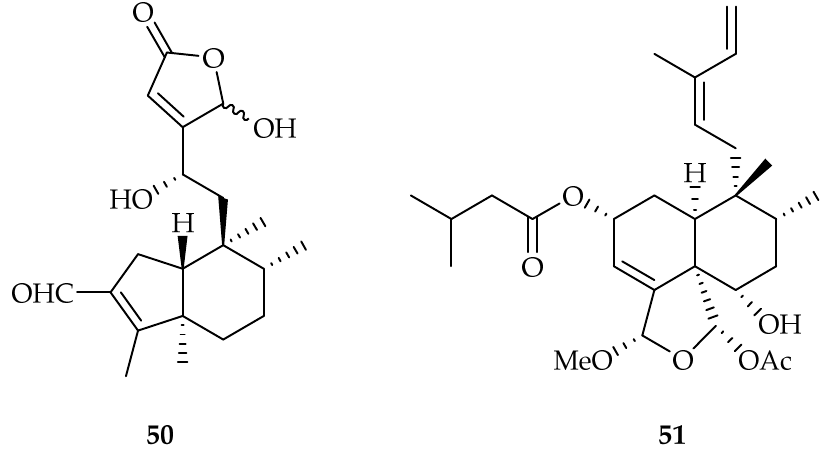
Figure 21. Structures of 16-hydroxy-pentandralactone 50 [33] and caseargrewiin M 51 [34]. Methanolic extraction and subsequent partitioning with EtOAc of the fresh ripe fruits of Cesearia grewiifolia (Flacourtiaceae) led to the isolation of the new clerodane diterpene, which was named caseargrewiin M 51 [34] (Figure 21). Its structure was elucidated using basic 1D ( 1 H and 13 C) and 2D NMR (COSY, HSQC, HMBC, and NOESY) techniques. Cytotoxic activity of caseargrewiin M 51 was determined towards Hep-G2, SW-620, Chago-